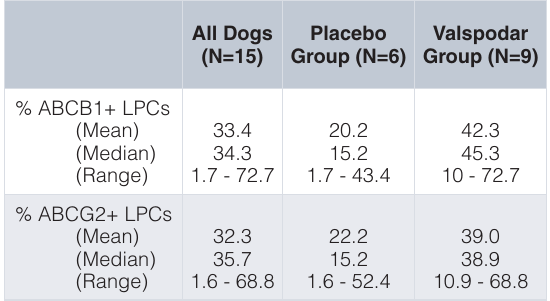
Table 5A. Frequency of ABCB1 + and ABCG2 + LPCs in lymph nodes.